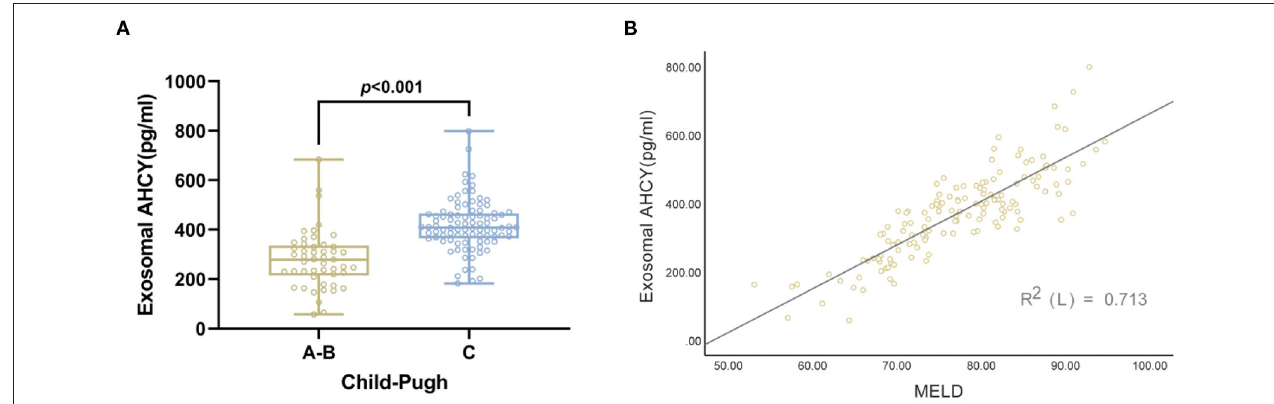
FIGURE 3 | Correlation between serum exosomal AHCY level and child Pugh and MELD score in HBV-LC patients group. (A) The level of serum exosomal AHCY in HBV-LC patient with grade C group was significantly higher than that in HBV-LC patient with Grade A, B group [408.70 (365.63–465.76) vs. 279.76 (215.16–336.07), P > 0.001]; (B) there was a significant positive correlation between serum exosomal AHCY levels and MELD score ( r = 0.844, P < 0.001).